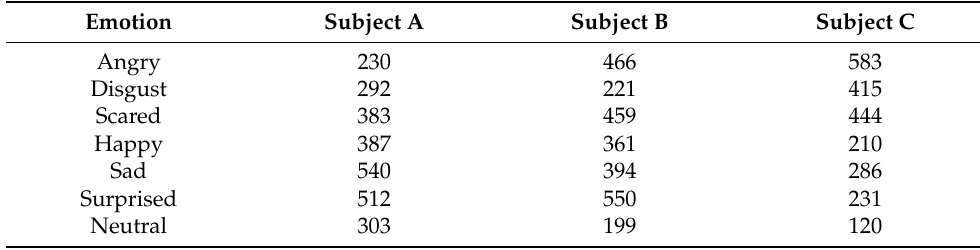
Table 7. Numbers of test frames for various